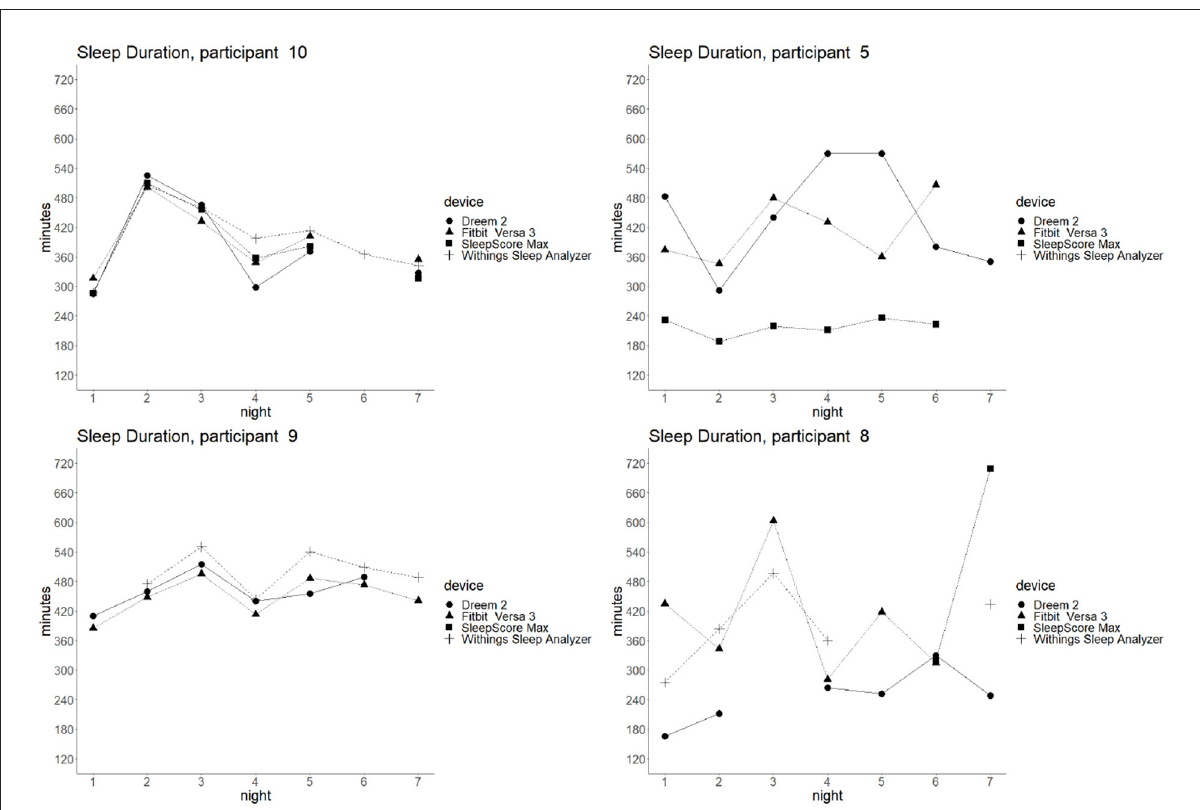
FIGURE4 Example of high/low variance in different devices: total sleep time of four participants per each night by different devices. On the left, range of P10 and P9 sleep tracking results is narrow. On the right, the sleep tracking data deviates more for participants P5 and P8.